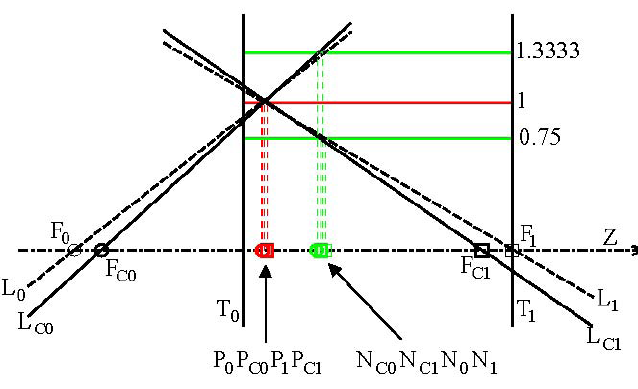
Figure 7 The locator lines and cardinal points of the visual sys- tem of the relaxed S and accommodated S C Gullstrand-Emsley schematic eye. There is an approximate pivot point at about 2 mm from T 0 . The principal points are located at about this longitudinal position; they are little affected by accommodation. Accommodation steepens the locator lines and, approximately speaking, draws all other special points towards the principal points.